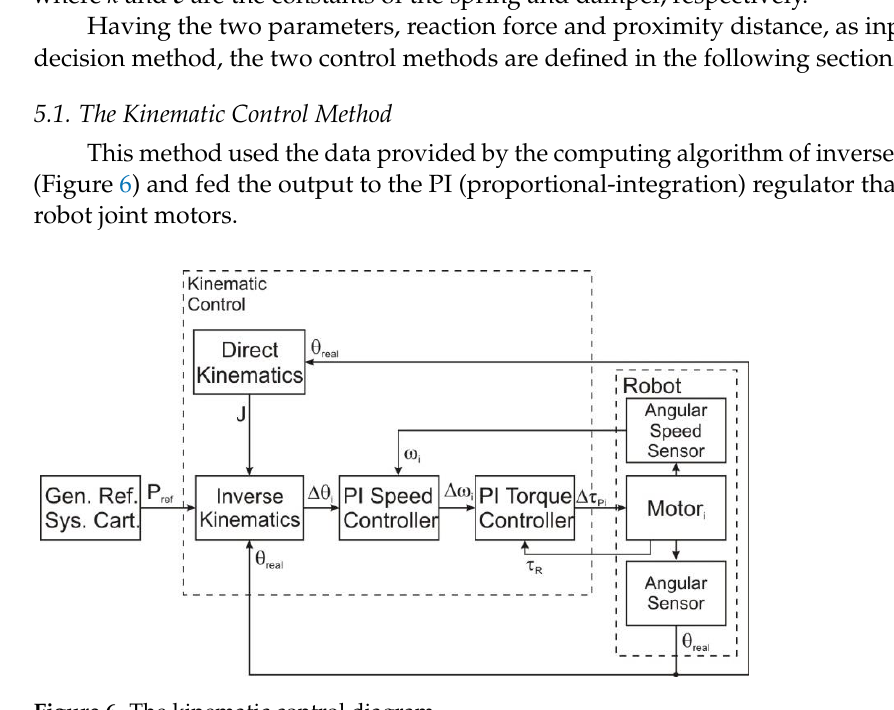
Figure 6. The kinematic control diagram.